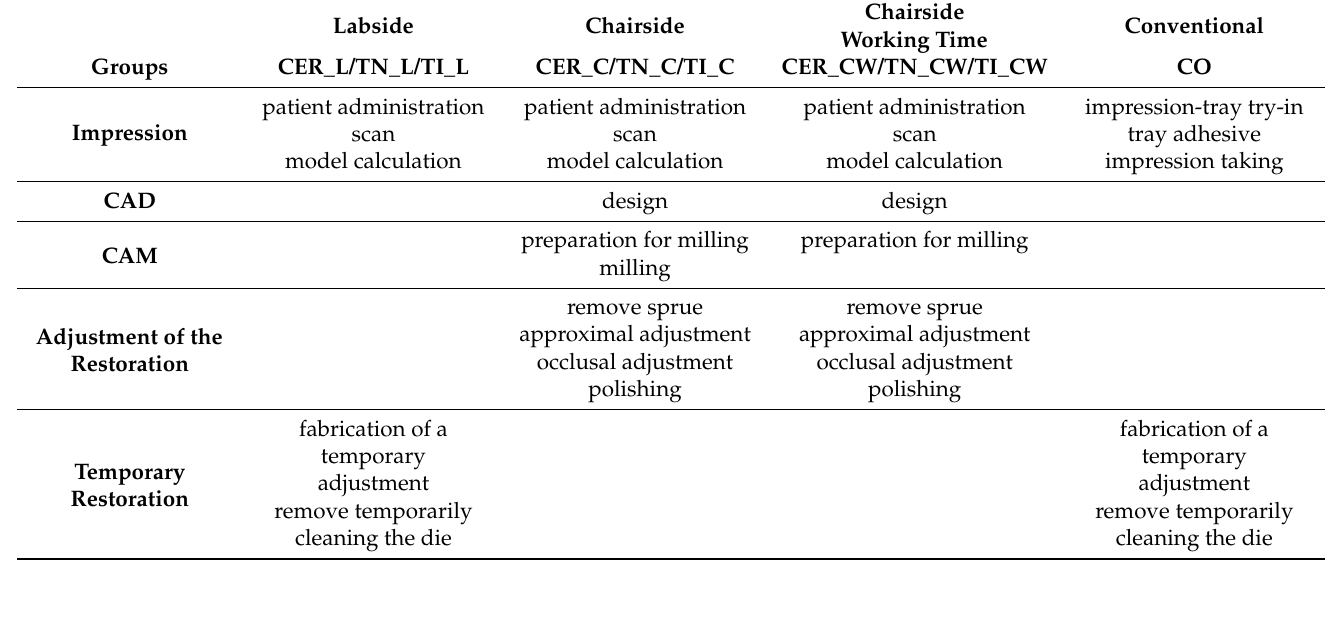
Table 2. Single steps of each workflow. The time for each step was measured using a stop clock.